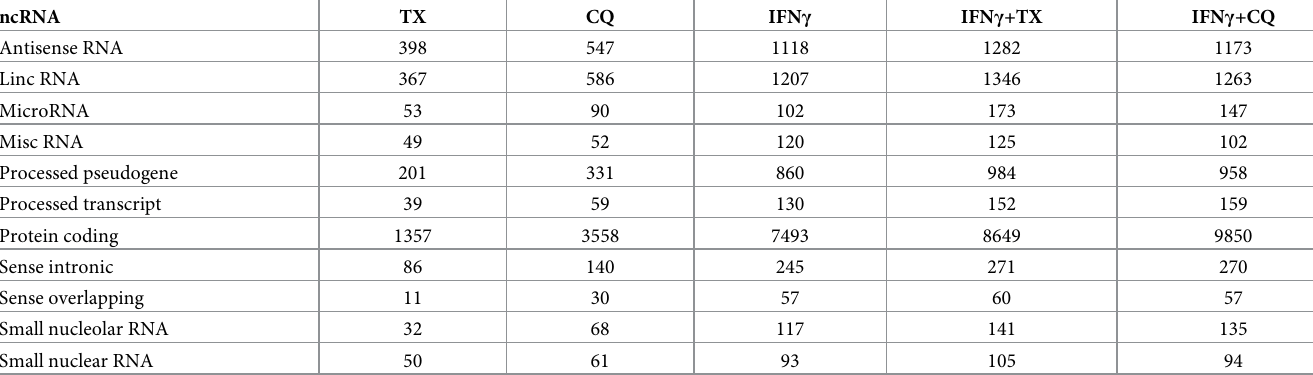
Table 1. Total number of differentially regulated RNA species (left column) resulting from indicated treatments (top row).